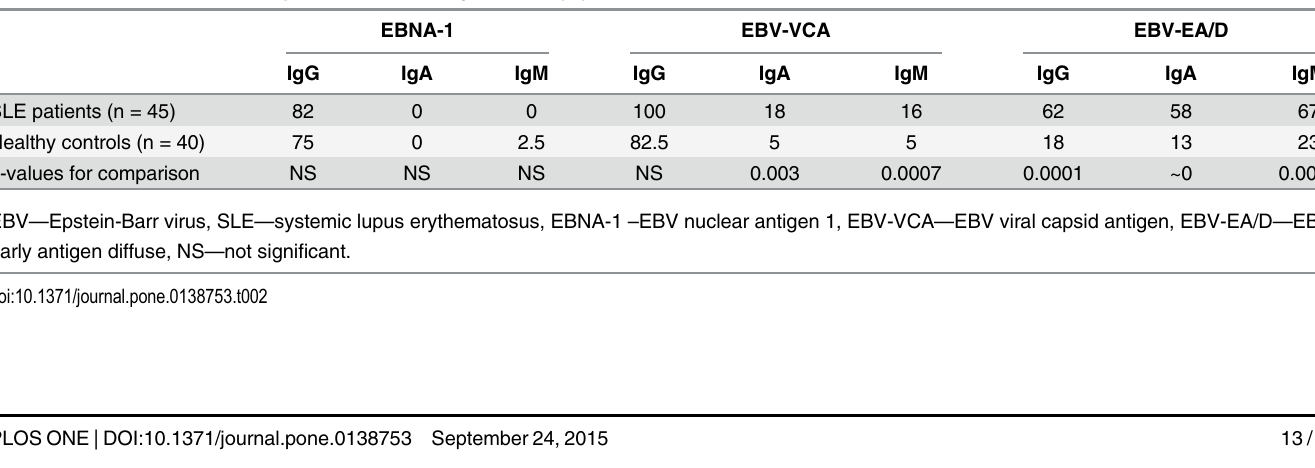
Table 2. EBV antibodies in SLE patients and healthy controls